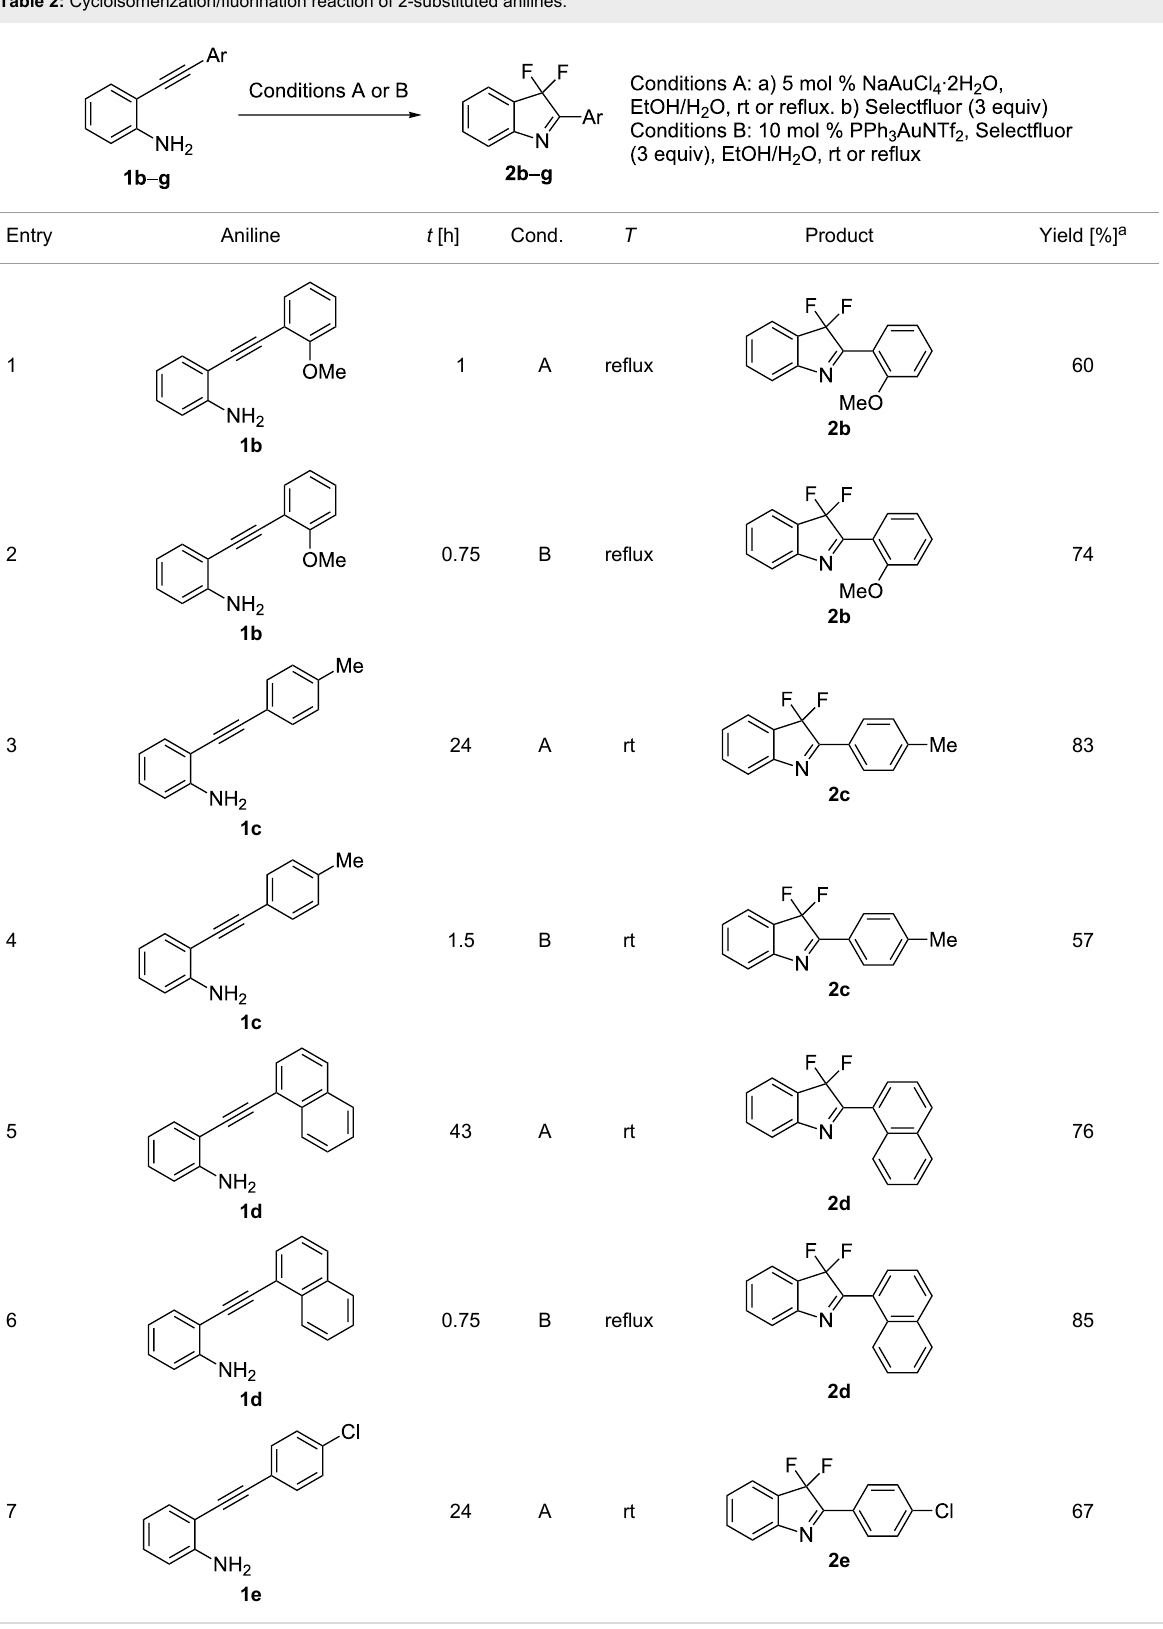
Table 2: Cycloisomerization/fluorination reaction of 2-substituted